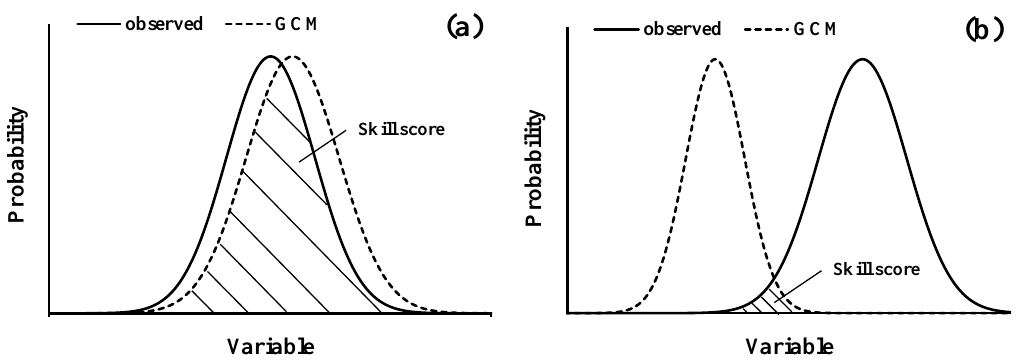
Figure 6. Diagrams of GCM vs observed PDF illustrating the total skill score in ( a ) a near-perfect skill score and ( b ) a very poor skill score.